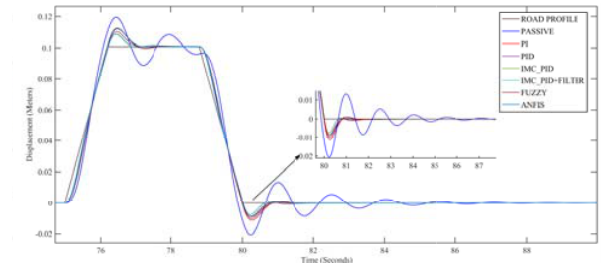
Figure 18. Response against Road profile 3